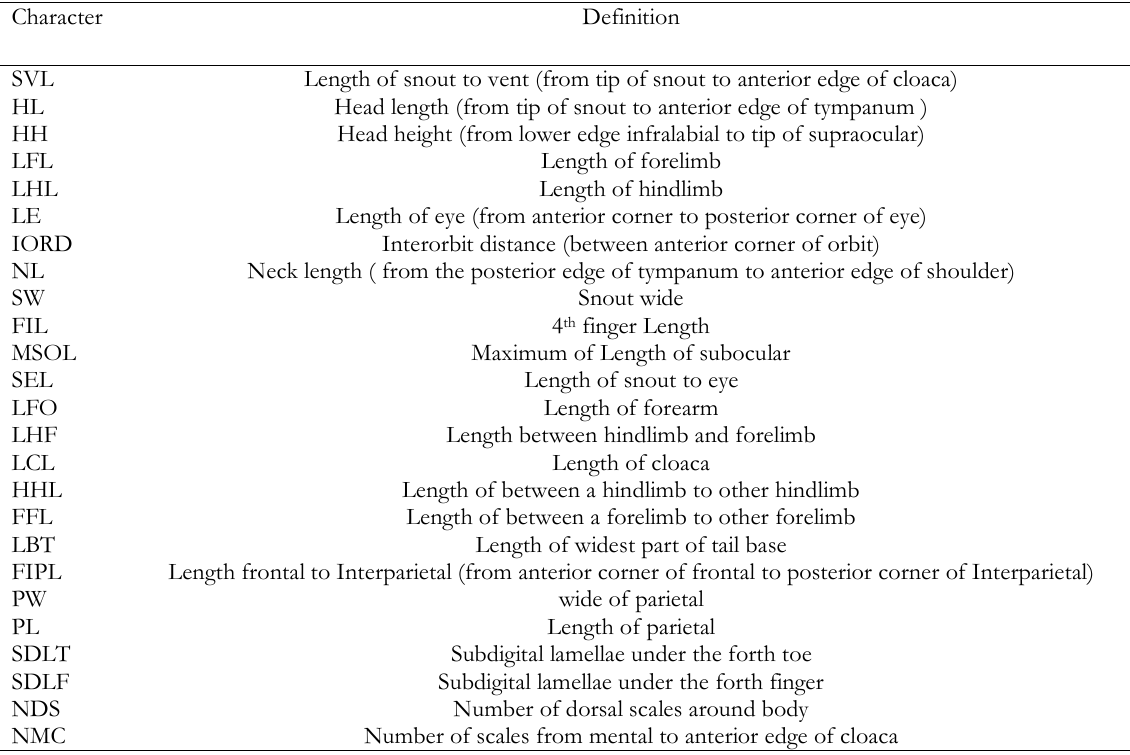
TABLE 1. The morphometric and meristic characters employed in geographic variation of T. vittata